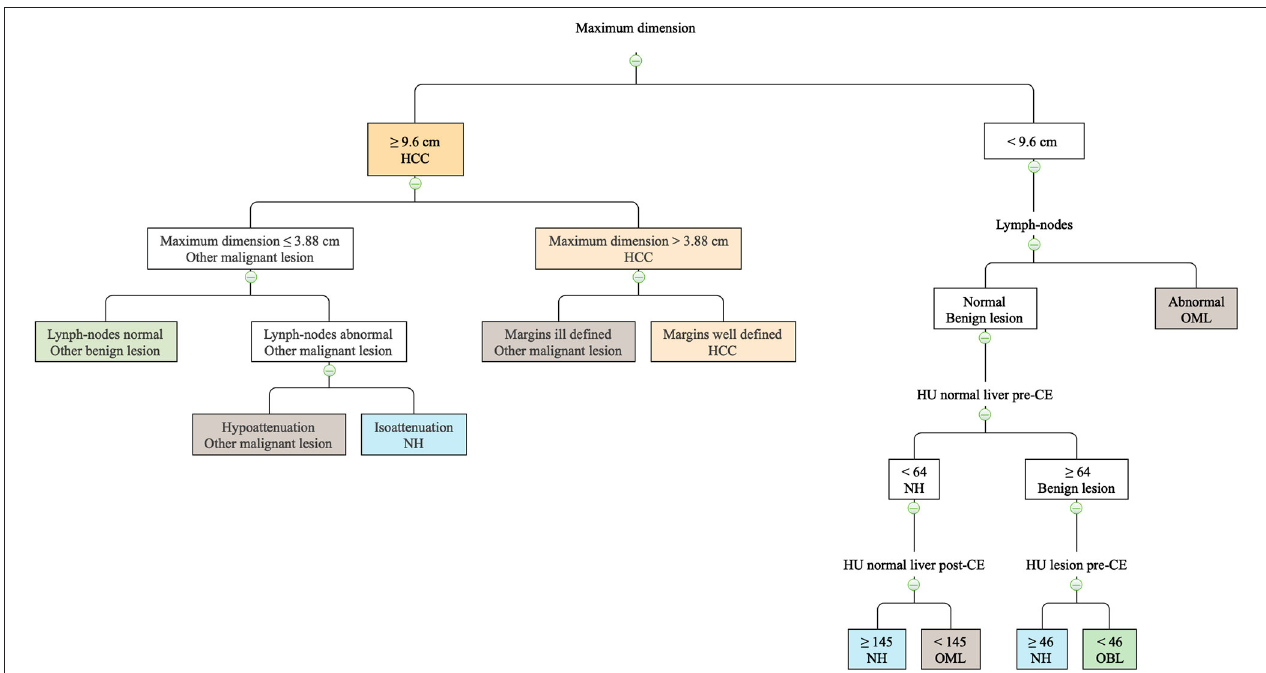
FIGURE 5 | The machine learning-based decision tree developed based on qualitative and quantitative CT features of the